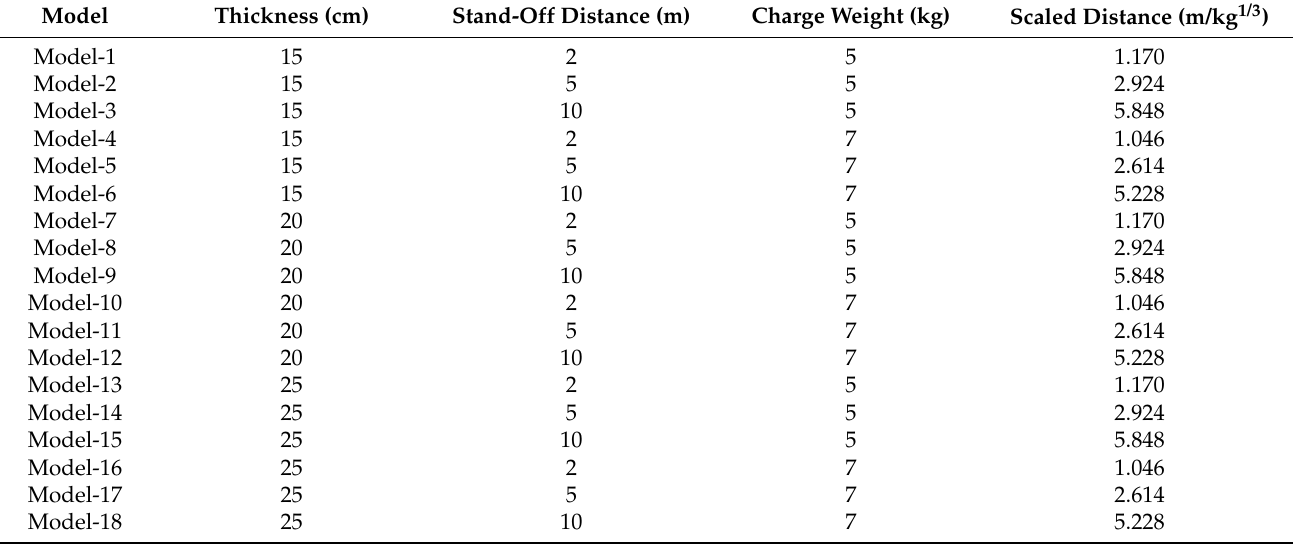
Figure 6. Boundary conditions of the walls: ( a ) fixed top and bottom of the wall; ( b ) fixed sides and bottom of the wall; ( c ) fully fixed BCs. Table 3. Details of the studied models.